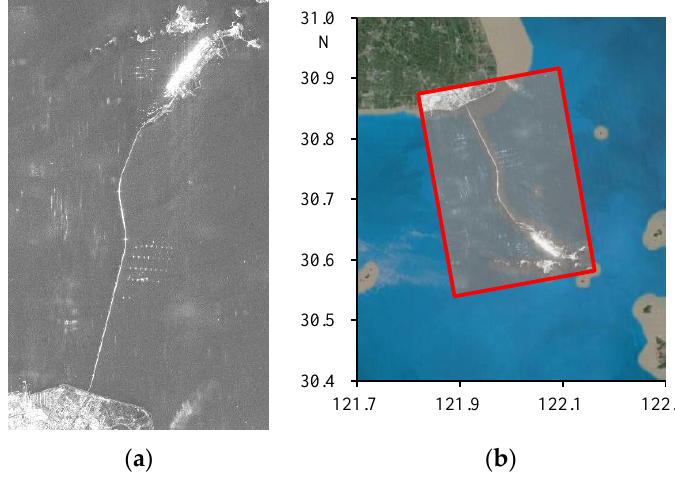
Figure 2. Synthetic aperture radar (SAR) image ( a ) containing large water bodies and its corresponding geographic location ( b ).